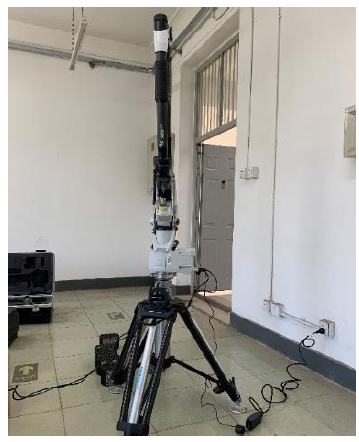
Figure 3. 3D laser scanning equipment.